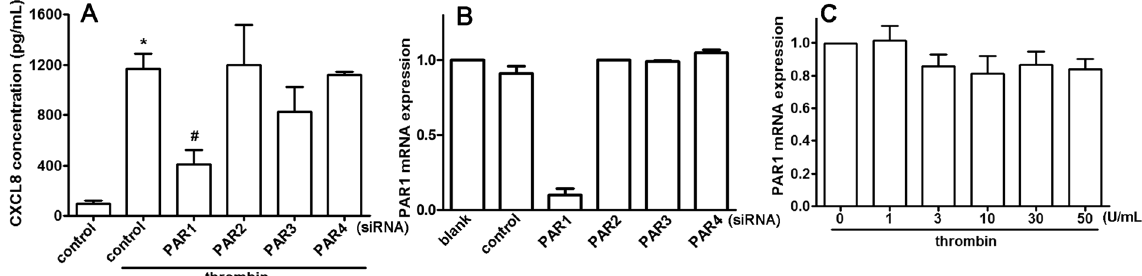
Figure 3. Thrombin-enhanced CXCL8 expression through PAR1 receptor. ( A ) NP cells were transfected with siRNA against PAR1, PAR2, PAR3, or PAR4, or the non-targeting control, for 24 h followed by treatment with thrombin (10 U/mL) for another 24 h, and then CXCL8 protein levels were determined by ELISA. Each bar represents the mean ± S.E.M. from at least three independent experiments performed in duplicate. ( B ) NP cells were transfected with siRNA against PAR1, PAR2, PAR3, or PAR4 for 24 h. ( C ) NP cells were treated with various concentrations of thrombin for 4–6 h. The gene expression of PAR1 receptor was determined by